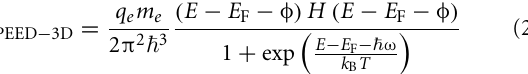
FIGURE 3 | Current densities resulting from thermionic current density (Eq. 10), semiconductor current density (Eq. 23), and PETE type current density (Eq. 24) for m * = 0.5 m e , φ = 0.9eV, and ( E F,n − EF) = 0.1eV